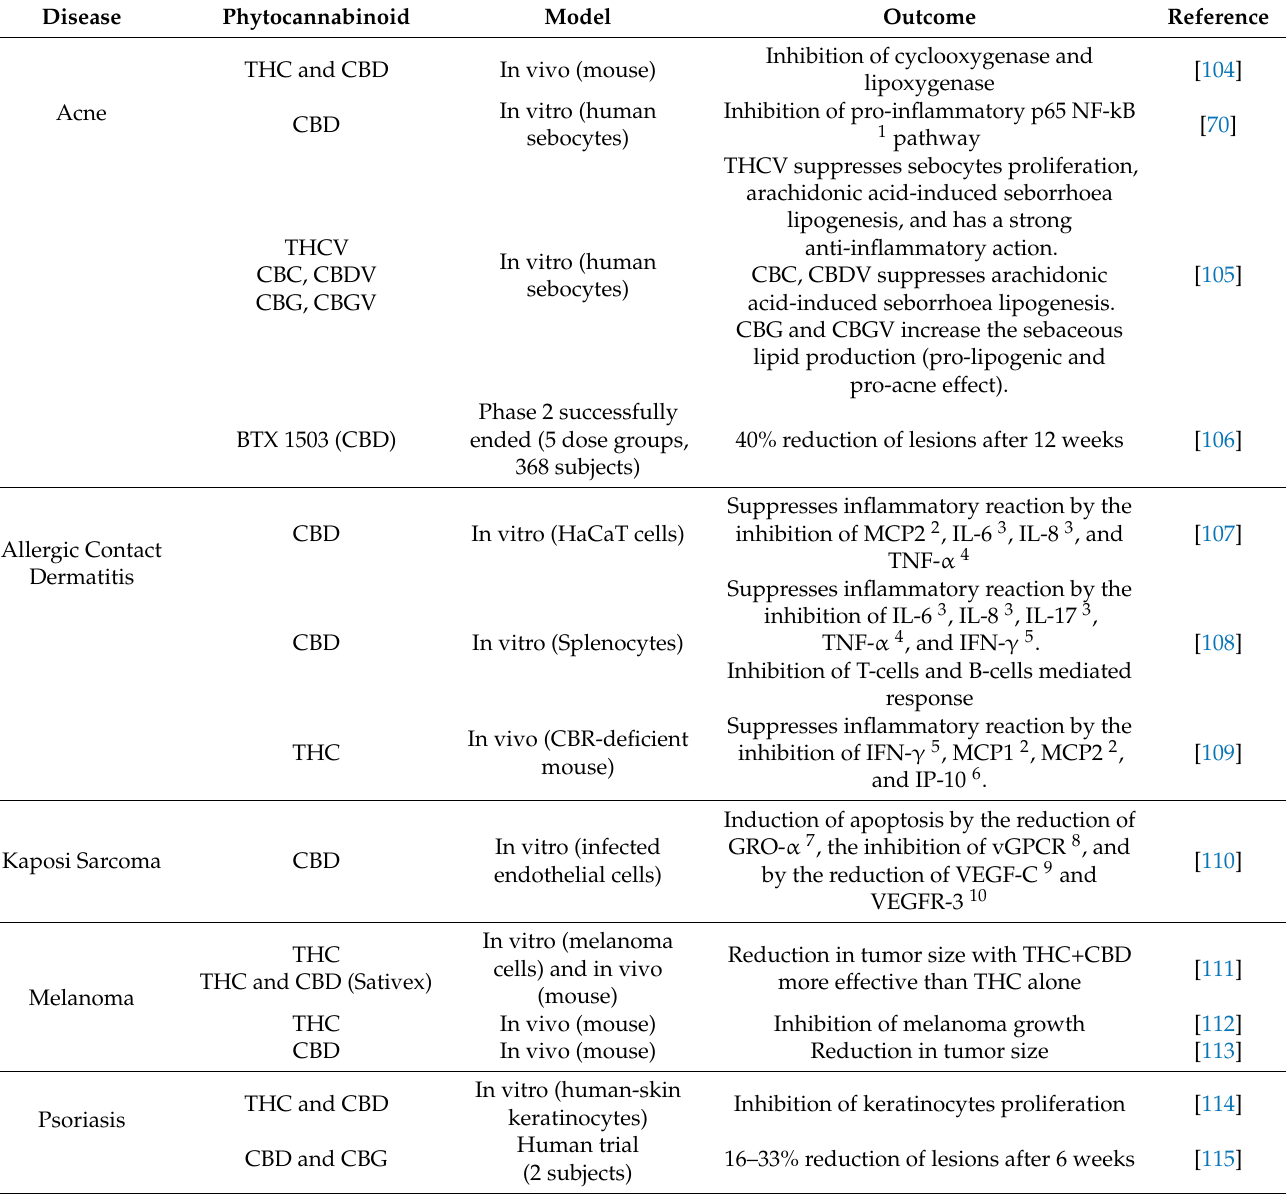
Table 3. Clinical evidence of the therapeutical potential of various cannabinoids.